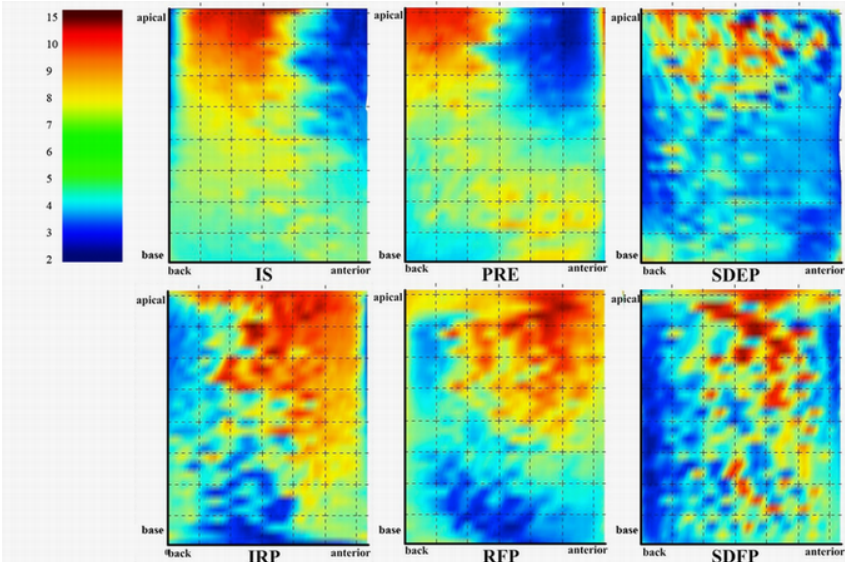
Figure 4. LVMA color graph of 6 CPPs. The color band in left column indicates the value of